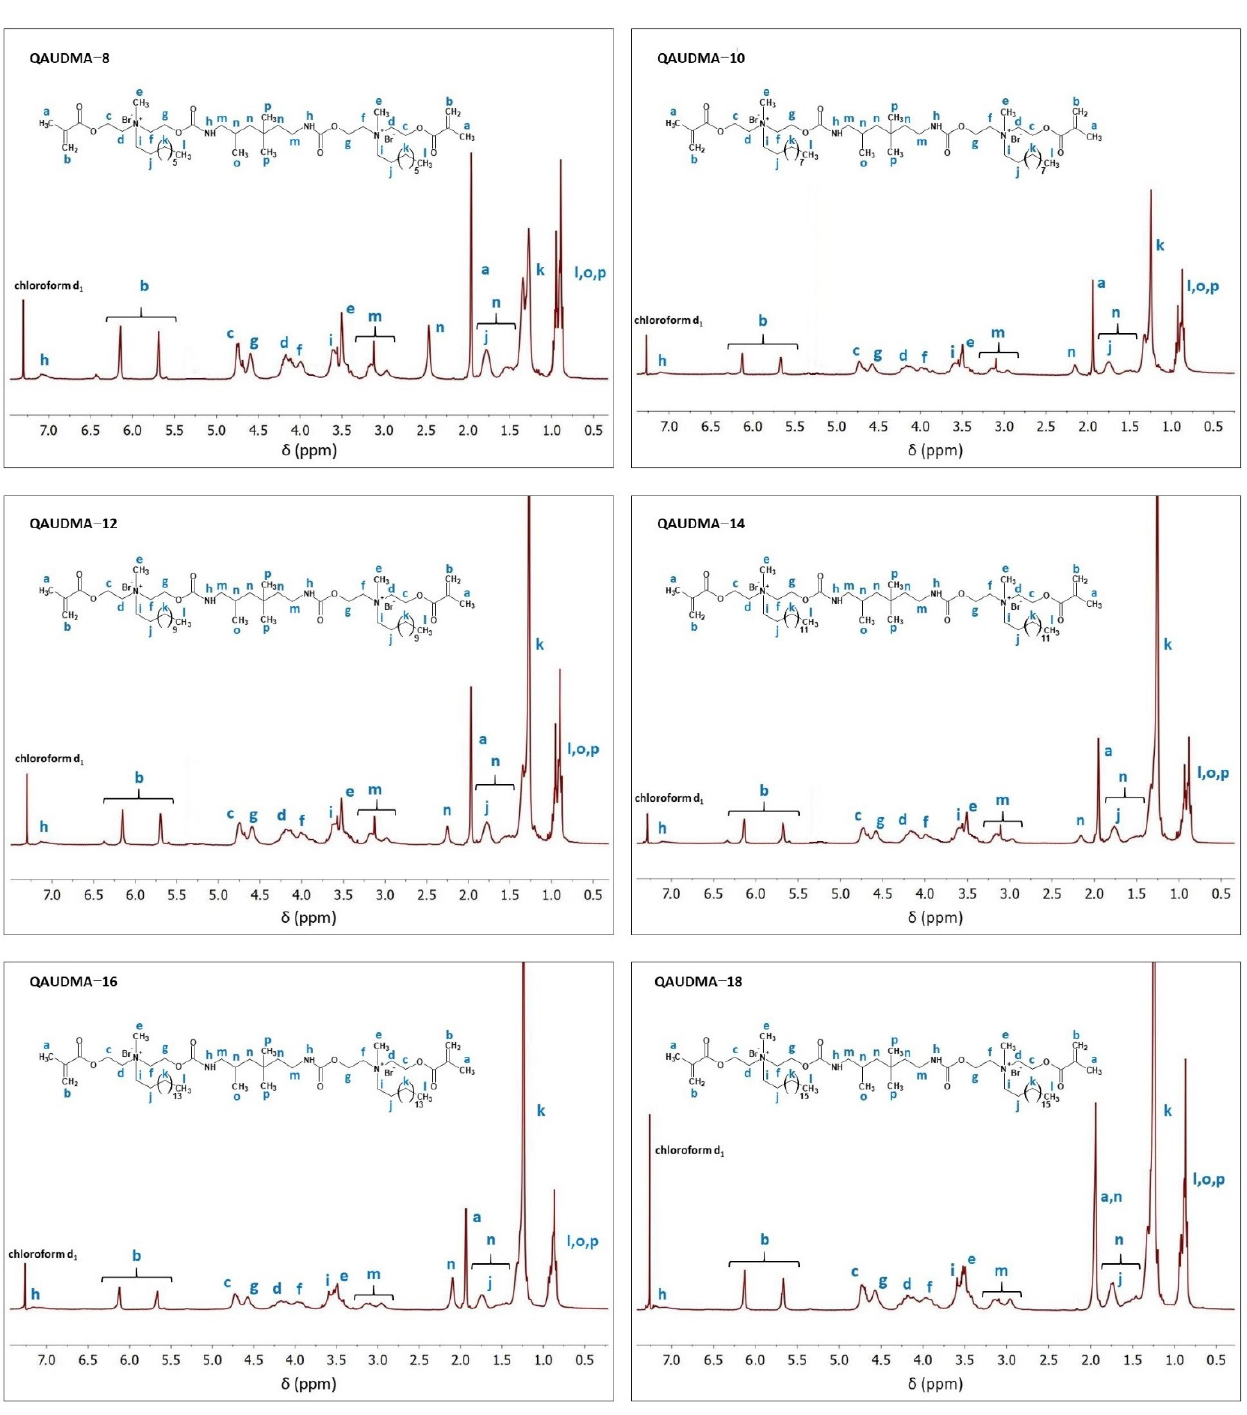
Figure 5. 1 H NMR spectra of QAUDMAs.